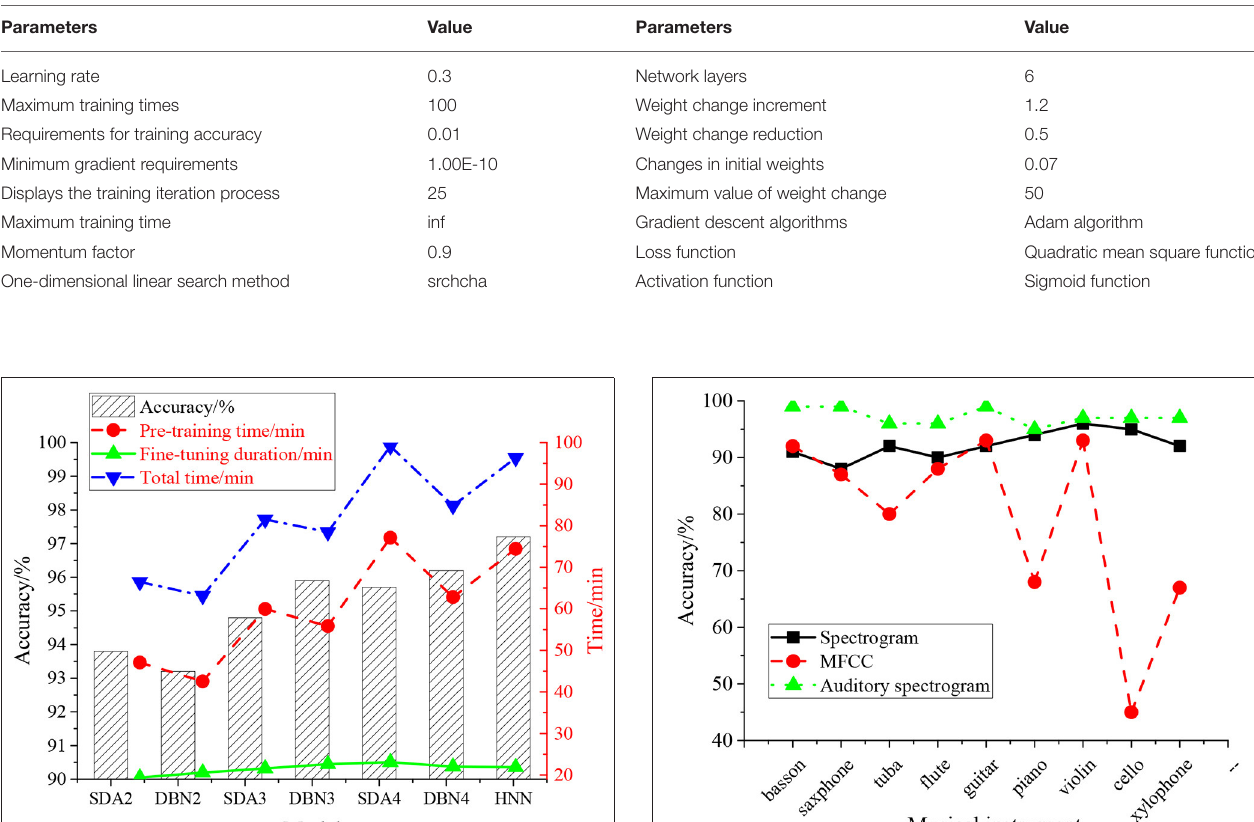
TABLE 3 | Hyperparameters setting.